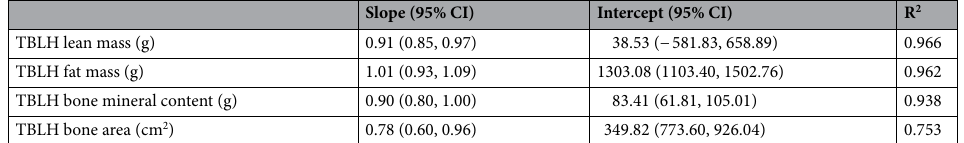
Table 4. Cross-calibration equations between GE Lunar Prodigy basic and GE Lunar iDXA (reference) measurements among 28 young